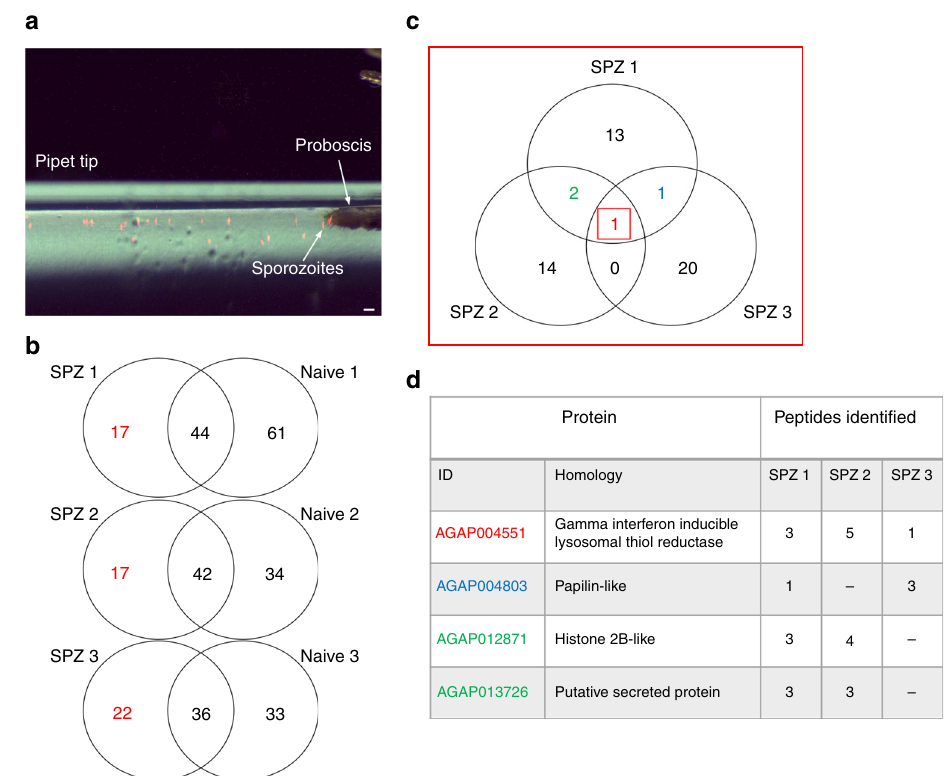
Fig. 1 Mass spectrometry identi fi ed AGAP004551 in association with sporozoites puri fi ed from mosquito saliva. a An image depicting the collection of Plasmodium sporozoites from the saliva of infected mosquitoes in a pipet tip (sporozoites in red, scale 10 μ m). b The mosquito proteins associated with sporozoites collected from saliva of infected mosquitoes (SPZ) were compared to residual mosquito proteins from naive saliva (naive) by LC MS-MS. Three independent biological replicates were used. Each Venn diagram represents the A. gambiae proteins associated with each fraction ( n = 35 – 50 mosquitoes/sample). The numbers in red indicate proteins that were only present in the samples from Plasmodium -infected mosquitoes. c The A. gambiae proteins unique to each SPZ sample were then compared to each other to determine potential common proteins. d AGAP004551 was identi fi ed in all three experiments and several peptides were discerned in two of the experiments. The proteins identi fi ed in two of the independent experiments are highlighted in blue and green,